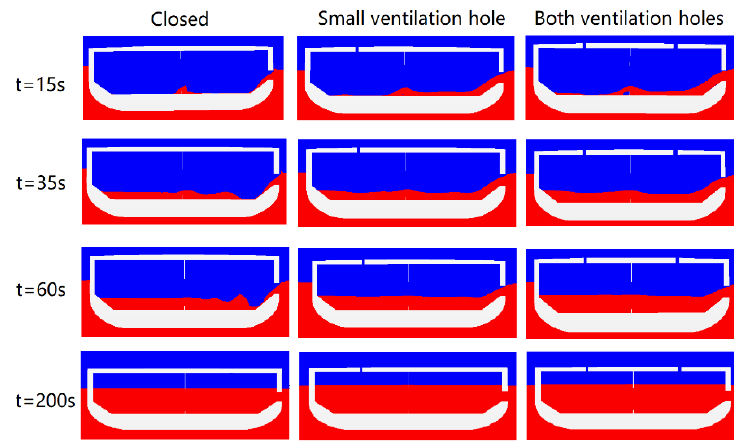
Figure 11. The flooding differences between various ventilation cases.